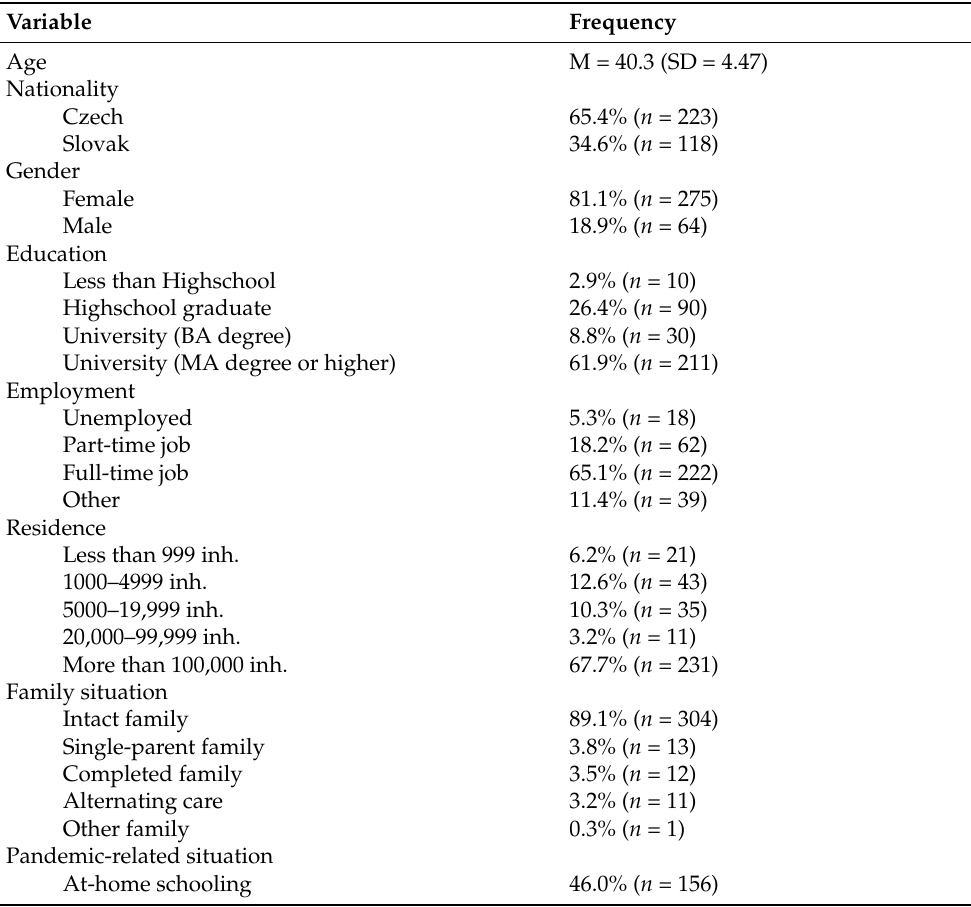
Table 1. Characteristics of the